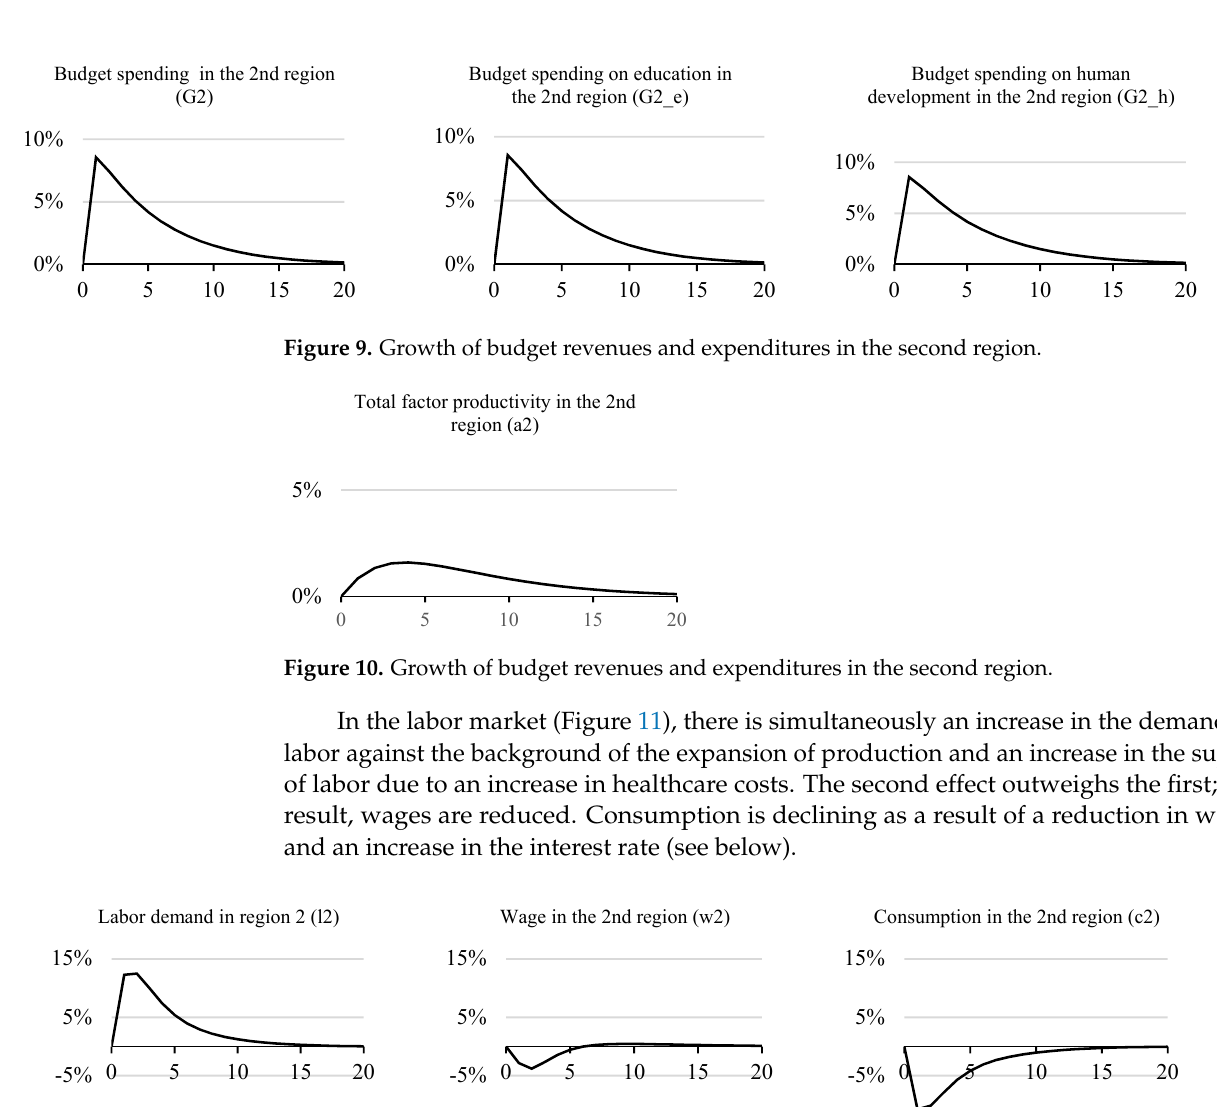
13 of 18 Figure 8. Output growth in the second region. A positive output gap in the second region triggers the following chain of budget effects—tax revenues increase, which proportionally increases both current budget pur-